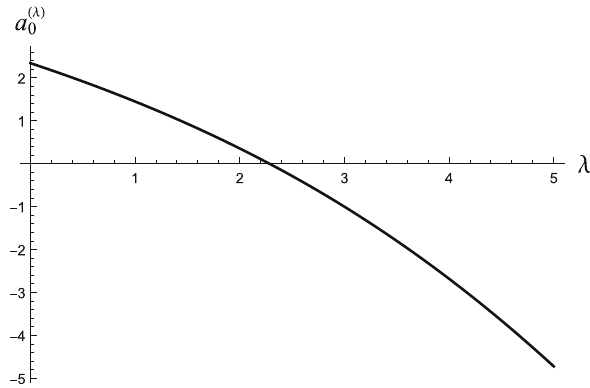
on the reduced 0